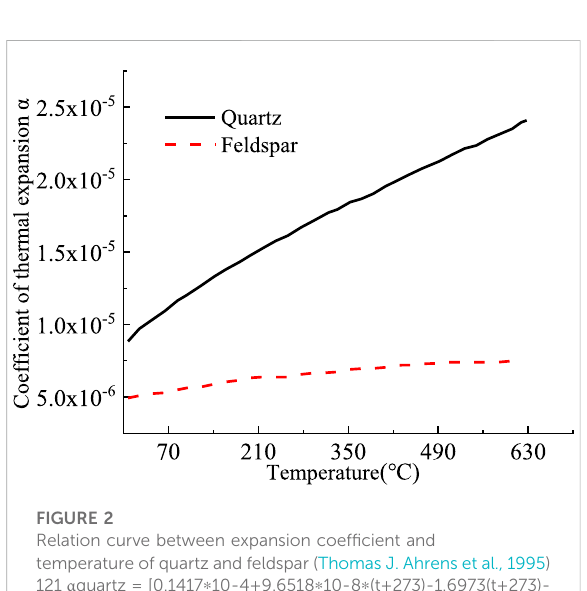
FIGURE 2 Relation curve between expansion coef fi cient and temperature of quartz and feldspar (Thomas J. Ahrens et al., 1995) 121 α quartz = [0.1417 p 10-4+9.6518 p 10-8 p